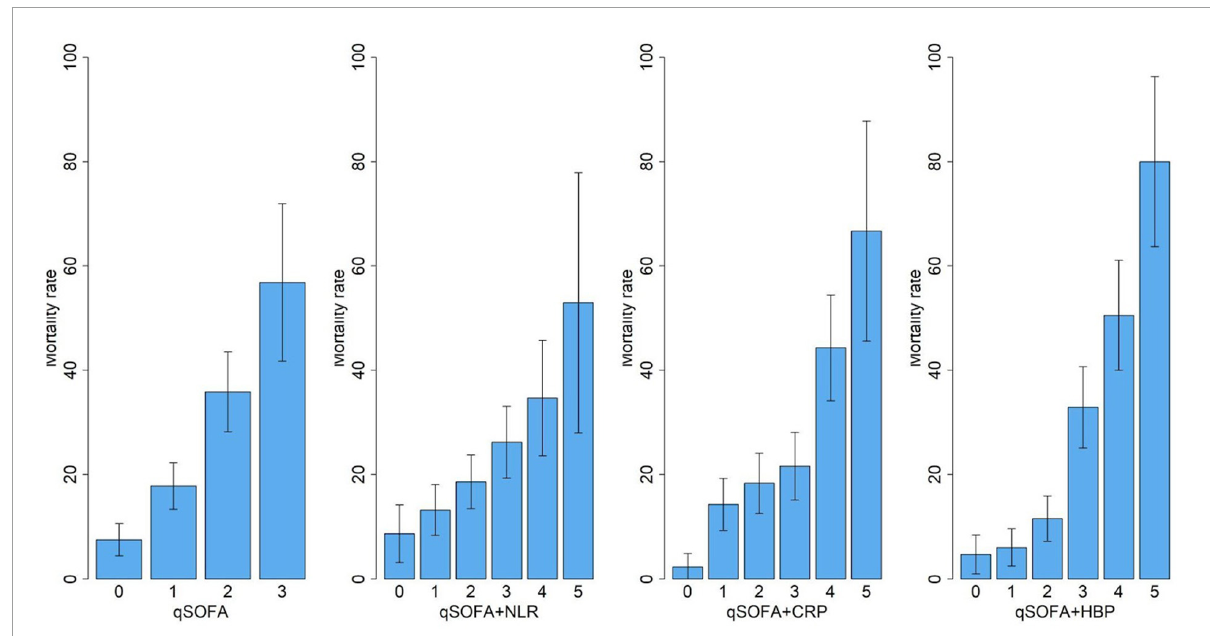
FIGURE3 Calibration of qSOFA, qSOFA-NLR, qSOFA-CRP and qSOFA-HBP. Hosmer-Lemeshow Chi-square is 0.90 for qSOFA score only ( P = 0.34),3.64 for qSOFA_HBP ( P = 0.30), 2.52 for qSOFA_NLR score ( P = 0.47), and 7.70 for qSOFA_CRP score ( P = 0.05).